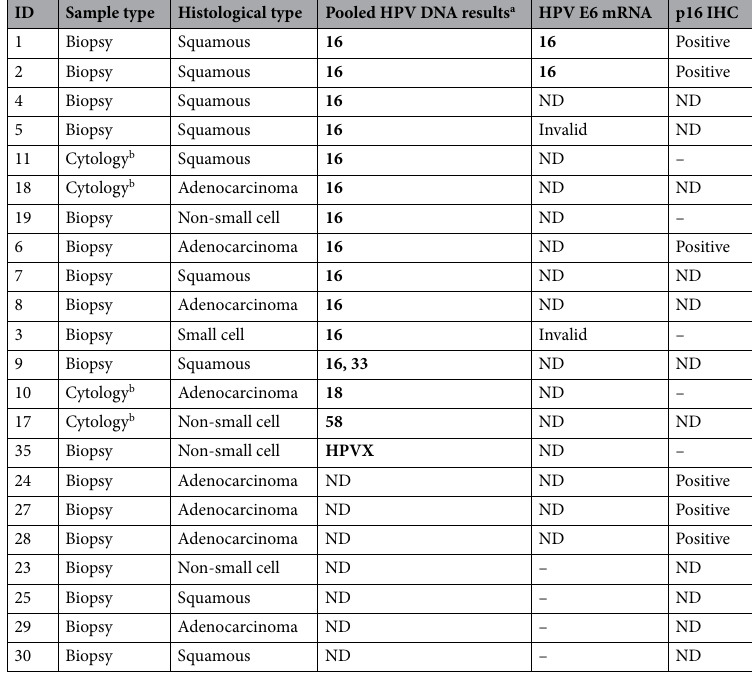
Table 3. Detection of human p16, HPV DNA, and HPV E6 mRNA in selected specimens. IHC immunohistochemistry, ND not detected, – not performed. a Pooled HPV DNA results from Table 2. b Cytology paraffin